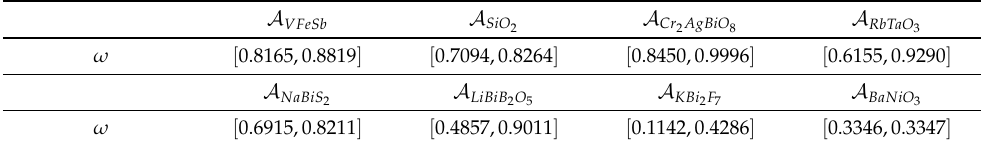
Table 3. Bound estimations of the quotient for the residual ω